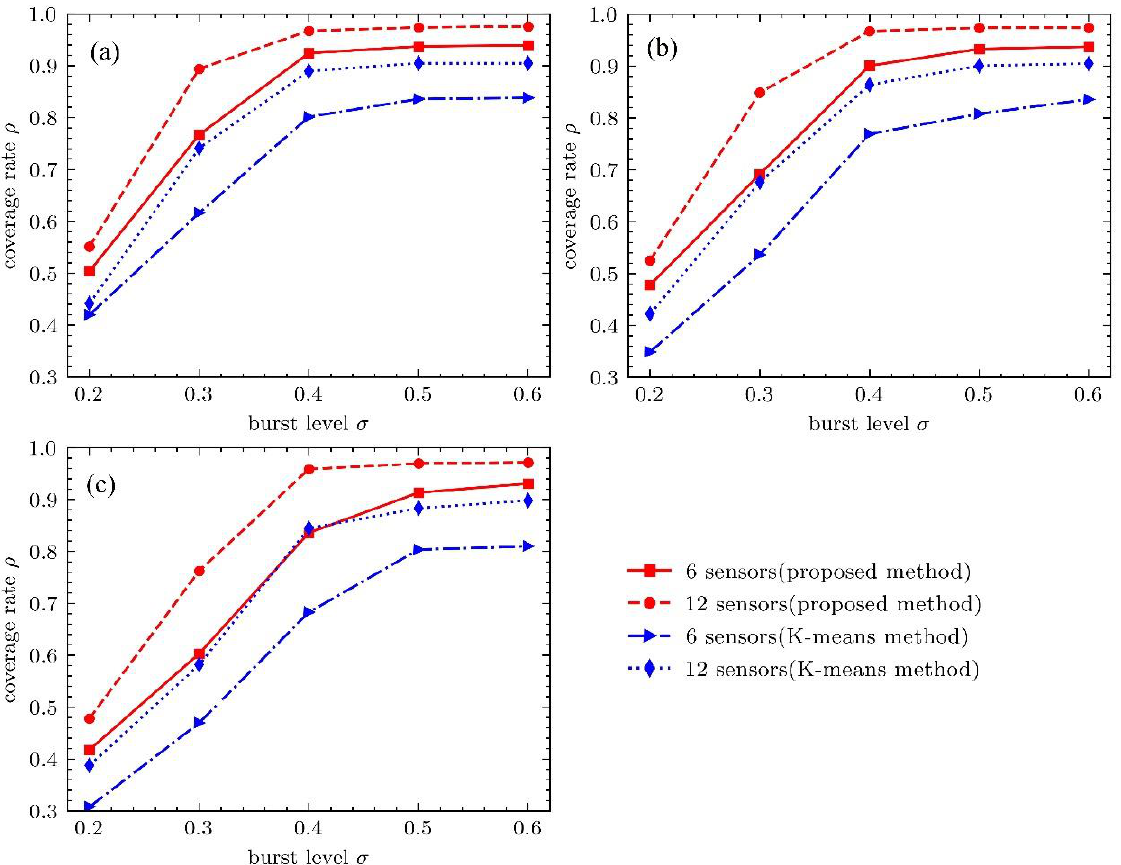
Figure 9. Coverage rates of different sensor placement schemes. The abscissa of the chart represents the level of pipe burst, the ordinate represents the coverage rate, the red curve represents the proposed method, and the blue curve represents the K-means clustering method. ( a – c ) represent the coverage rates of different monitoring schemes at average flow, maximum flow and minimum flow, respectively.